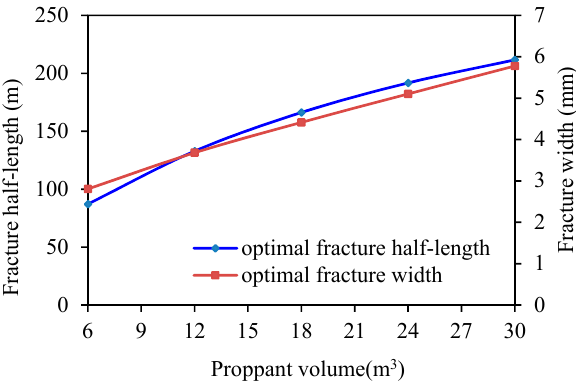
Figure 19. Optimal fracture half-lengths and widths vs. injected proppant volume.